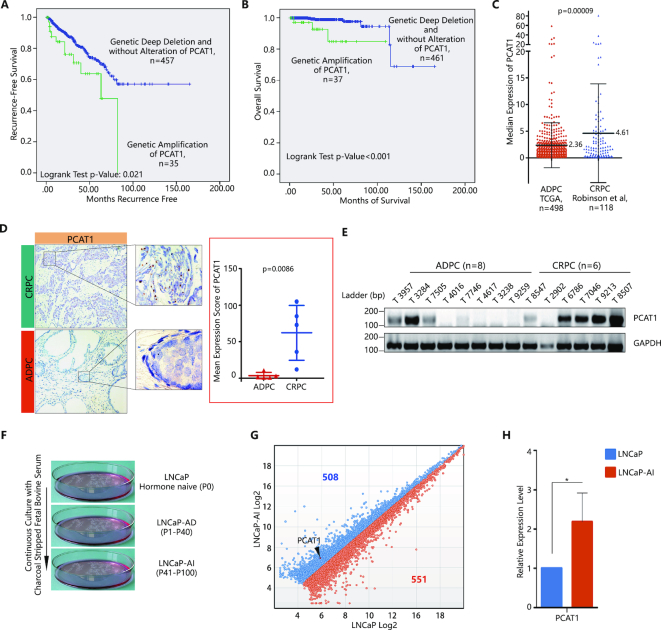
LncRNA-PCAT1 expression is correlated with castration-resistant prostate cancer. (A) Kaplan–Meier curve of the recurrence-free survival rates in prostate cancer patients with and without genetic amplification of PCAT1 (P = 0.021). Those without PCAT1 amplification included samples with deep deletion (n = 3) as well as those without alteration of PCAT1. The Cancer Genome Atlas data were retrieved from cBioPortal. (B) Kaplan–Meier curve of the overall survival rates in prostate cancer patients with and without genetic amplification of PCAT1 (P < 0.001). Those without PCAT amplification included samples with deep deletion (n = 3) as well as those without alteration of PCAT1. The Cancer Genome Atlas data were retrieved from cBioPortal. (C) Median expression of PCAT1 from two independent PCa patients’ RNA-seq data sets based on the value of FPKM. TCGA, The Cancer Genome Atlas; ADPC, androgen dependent prostate cancer; CRPC, castration-resistant prostate cancer. In dot plots, the center line is the median, with each dot depicting the FPKM value of each patient. The P value was determined by two-tailed t-tests. (D) RISH detection of PCAT1 expression in ADPC versus CRPC. Left panel: representative images; right panel: statistical analysis of five ADPC patient specimens and five CRPC patient specimens. (E) RT-PCR analysis of PCAT1 in fresh surgical specimens from patients with CRPC (n = 6) and ADPC (n = 8). GAPDH was used as a loading control. (F) Flowchart showing establishment of the androgen-independent LNCaP-AI cell line. The androgen-independent LNCaP-AI cell line was generated by long-term culture of androgen-dependent LNCaP cells in RPMI-1640 medium containing charcoal-stripped serum. LNCaP-AD, Androgen-dependent LNCaP cell line; LNCaP-AI, Androgen-independent LNCaP cell line. P, passage. (G) Scatter plots of lncRNAs significantly upregulated (blue) or downregulated (orange) in LNCaP-AI compared to LNCaP cells. X and Y axes are normalized signal values (log2 scaled) for each gene, with PCAT1 labeled by a red plot. (H) qRT-PCR detection of PCAT1 expression in LNCaP and LNCaP-AI cell lines, normalized by the level of GAPDH. A P-value of <0.05 was considered significant. *represents P < 0.05, **represents P < 0.01 and ***represents P < 0.001.